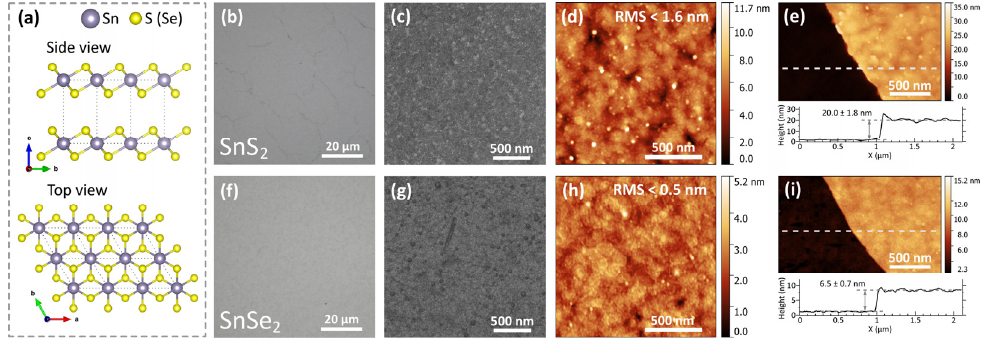
Figure 1. Morphology of SnS 2 and SnSe 2 . ( a ) Crystal lattice structure of 1T-SnS 2 (or 1T-SnSe 2 ) [44], optical microscopy images of ( b ) SnS 2 and ( f ) SnSe 2 . SEM images of ( c ) SnS 2 and ( g ) SnSe 2 . AFM scan images of ( d ) SnS 2 and ( h ) SnSe 2 . AFM thickness measurements of ( e ) SnS 2 and ( i ) SnSe 2 films with characteristic step height profiles.